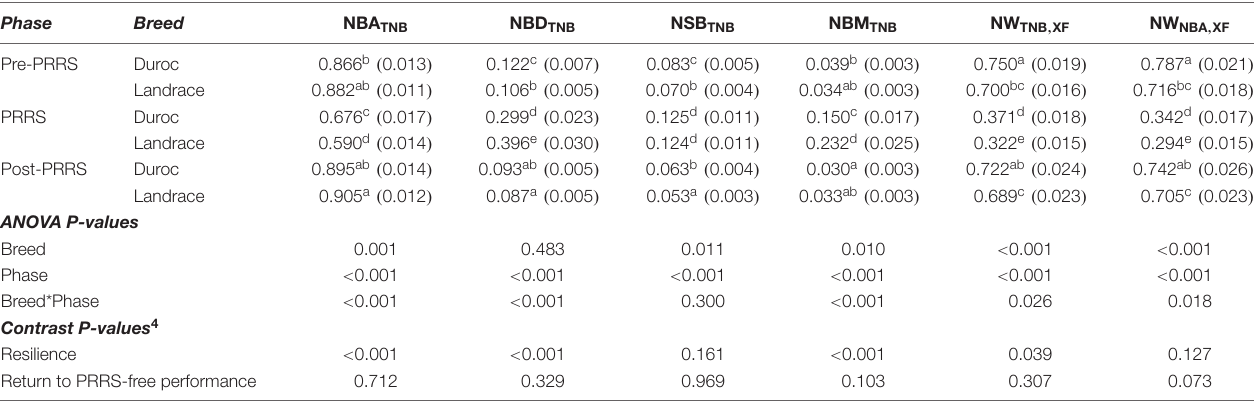
1 Results represented as proportions based on total number of piglets born (TNB), with or without the number of cross-fostered pigs (XF), or number of piglets born alive (NBA) with XF. Standard errors in parenthesis; 2 Porcine Reproductive and Respiratory Syndrome (PRRS); 3 NBA TNB , NBA with TNB used as the offset; NBD TNB , number of piglets born dead (NBD) with TNB used as the offset; NSB TNB , number of stillborn piglets (NSB) with TNB used as the offset; NBM TNB , number of mummified piglets (NBM) with TNB used as the offset; NW, number of piglets weaned; NW TNB , XF , NW with the sum of TNB and the net number of cross-fostered pigs (XF) used as the offset; NW NBA , XF , NW with the sum of NBA and XF used as the offset; 4 Resilience, contrast representing the differences between breeds for the difference between pre-PRRS and PRRS; Return to PRRS-free performance, contrast representing the differences between breeds for the difference between pre-PRRS and post-PRRS; a − e Means lacking the same superscript within a column indicate differences at P-value <